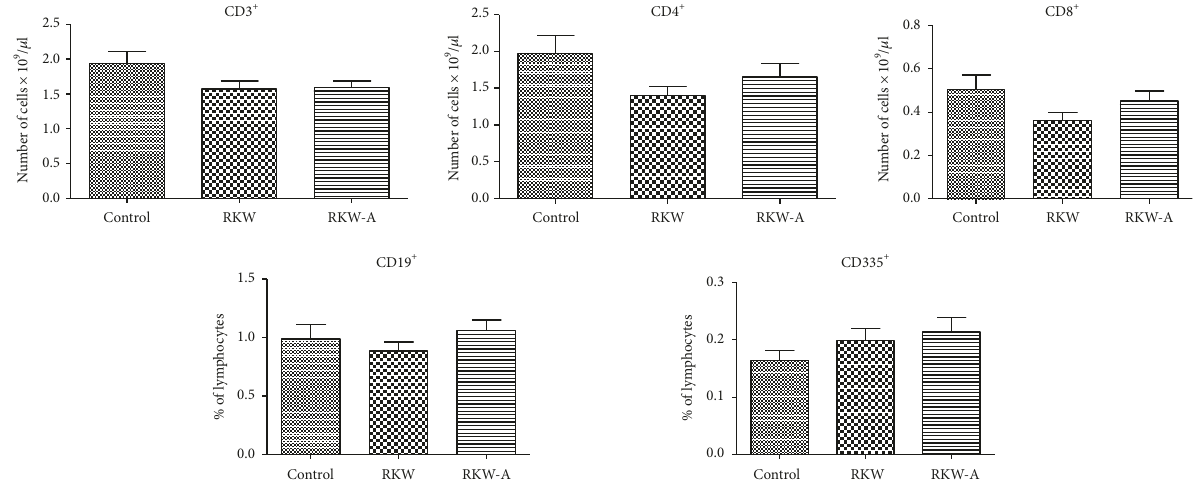
Figure 2: Blood lymphocyte phenotype analysis (cell number per μ l). Analysis was performed in the o ff spring of mothers fed during pregnancy and lactation with water (RKW) or hydroalcoholic (RKW-A) extract of Rhodiola kirilowii